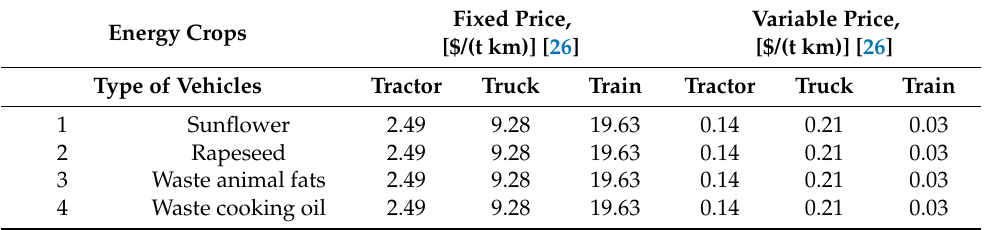
Table 6. Transport costs for different modes of transport for biomass [16].